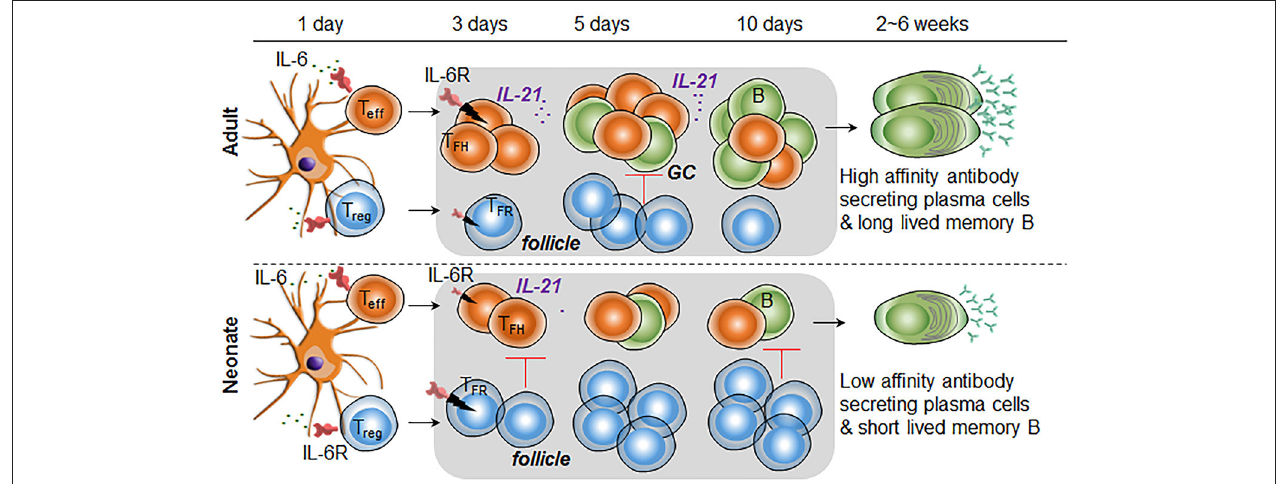
FIGURE 7 | Higher IL-6R expression on T FR cells than T FH cells is responsible for increased T FR : T FH ratio in immunized neonatal mice. In immunized neonatal mice, IL-6 (likely secreted from antigen presenting DCs) is unable to expand T FH cells because of diminished signaling, a likely consequence of lower IL-6R expression. In addition, elevated IL-6 activity in T FR cells leads to the expansion of this subset in neonates. Consequently, in response to IL-6, T FR cells populate the follicles and suppress the expansion of IL-21 expressing T FH cells and GC B cells. Diminished T FH and GC B cell formation leads to low number of plasma cell and short-lived memory cell